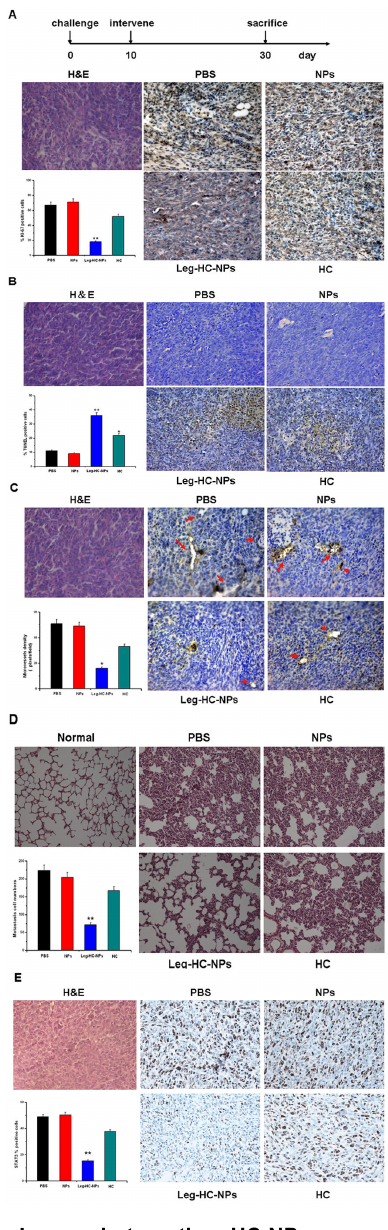
Figure 5. Legumain-targeting HC-NPs promoted tumor cells apoptosis and inhibits tumor cells proliferation, angiogenesis and pulmonary metastasis in vivo. . Tumor bearing mice were sacrificed at day 30 after 5 IV injections. (A) Expression of ki-67 in tumor sections was evaluated by immunohistochemistry (IHC). Original magnification: × 400. (B) TUNEL staining visualized and quantified the percentage of apoptotic tumor cells in tumor sections. Original magnification: × 400. (C) CD31-positive microvessel density was evaluated by counting at × 400 magnification. Arrows show positively-stained microvessels. (D) H&E staining demonstrates pulmonary metastasis in vivo. Original magnification: × 200. (E) Expression of STAT3 in tumor sections was evaluated by